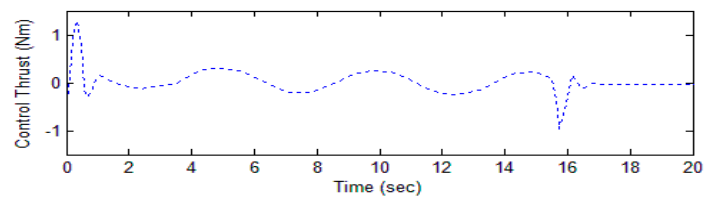
Figure 12. Control thrust of UAV under random noise or disturbance.